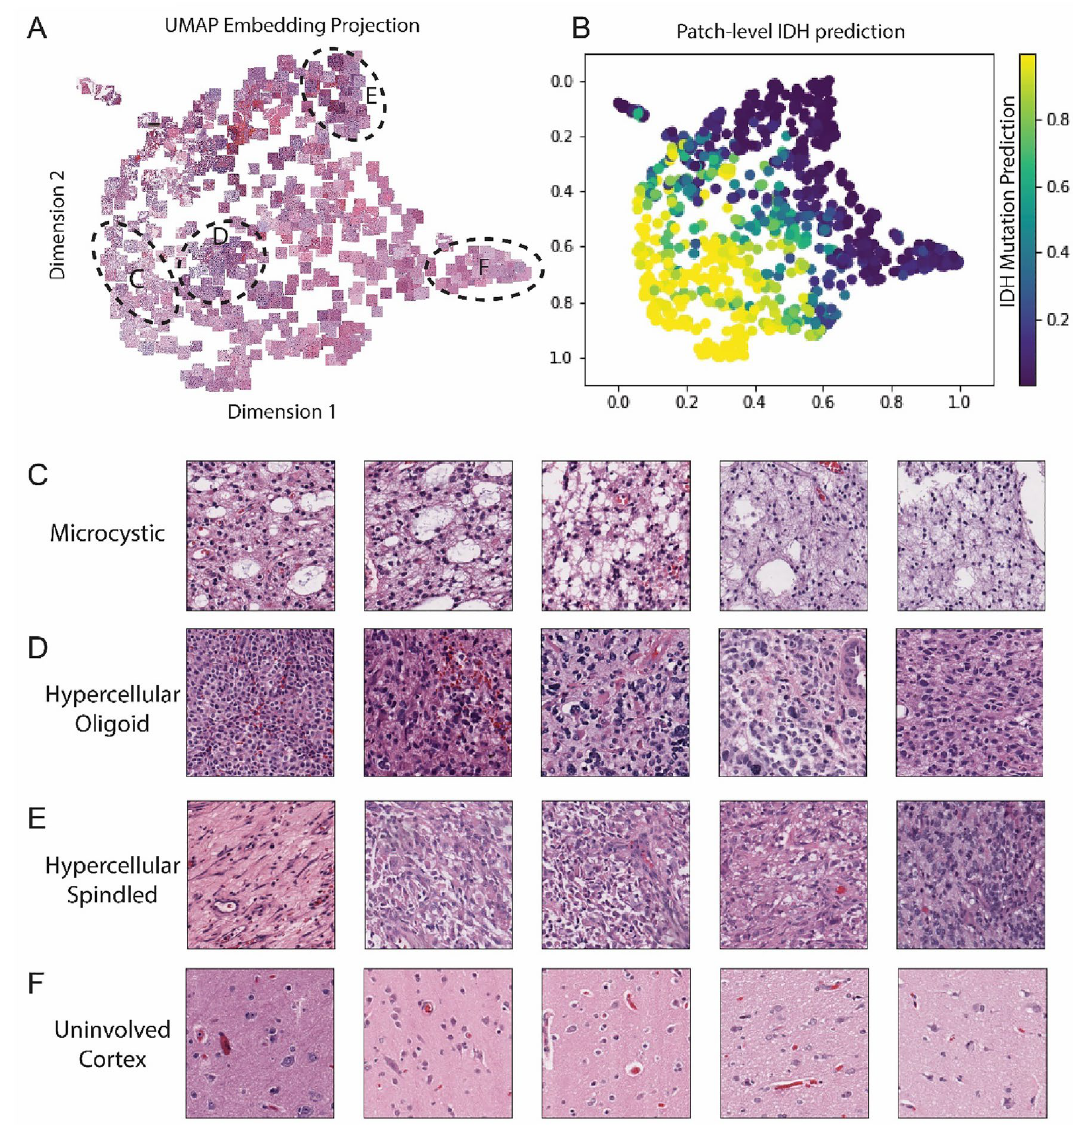
Figure 5. UMAP coordinates of the feature embedding vector activations from patches passed through the 10 × classifier. A ) shows some example tiles in 2D UMAP coordinates. ( B ) shows the patch-level IDH status prediction scores as predicted by the 10 × classifier. Tiles from region ( C ) demonstrate microcystic architecture. Tiles from region ( D ) demonstrate hypercellular regions of infiltrating tumor, with round cytology, enriched for tumors with oligodendroglial morphology. Tiles from region ( E ) demonstrate hypercellular regions of tumor with a greater degree of nuclear spindling/elongation and nuclear pleomorphism. Tiles from region ( F ) demonstrate brain parenchyma without significant infiltration by tumor